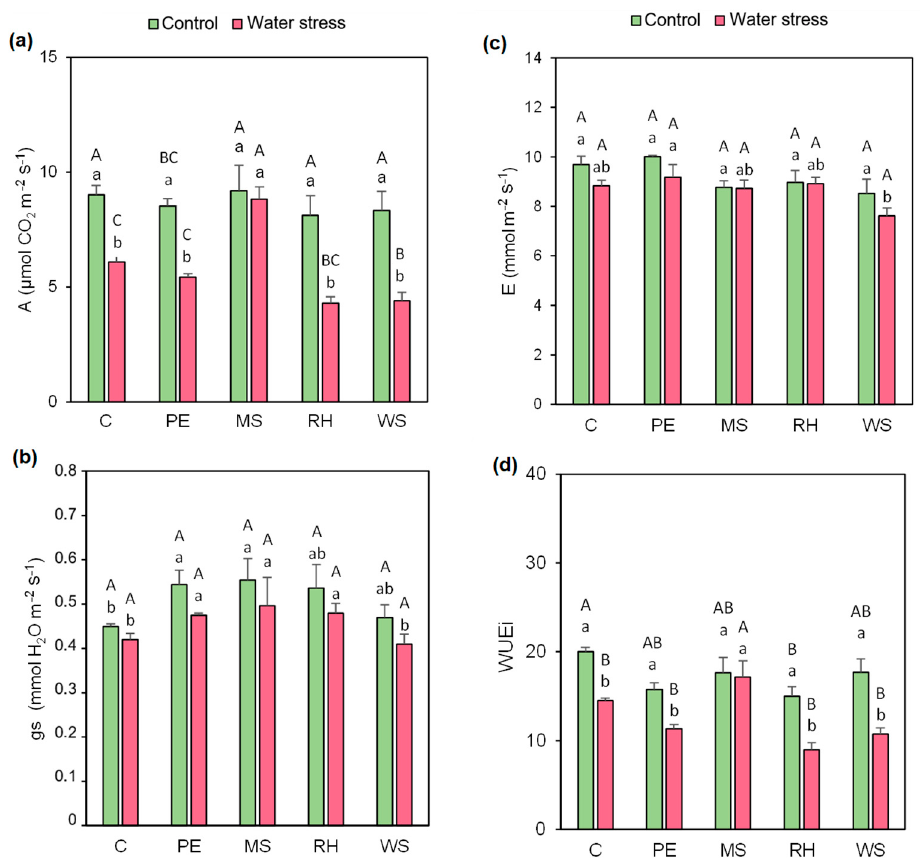
Figure 2. ( a ) Photosynthetic rate (A), ( b ) stomatal conductance (gs), ( c ) transpiration rate (E), and ( d ) intrinsic water use efficiency (WUEi) of escarole plants of the commercial variety “Brillantes” non-mulched or subjected to different mulching treatments and cultivated under control (well-watered) and water stress (70% ETc) conditions. Bars show the means of five plants ± standard error. Different capital letters indicate significant differences due to the water stress treatment while different small letters show significant differences among mulching treatments according to Tukey’s test ( p ≤ 0.05). Abbreviations used: non-covered substrate (C), polyethylene mulch (PE), mushroom substrate-based hydromulch (MS), rice hulls-based hydromulch (RH), and wheat straw-based hydromulch (WS).